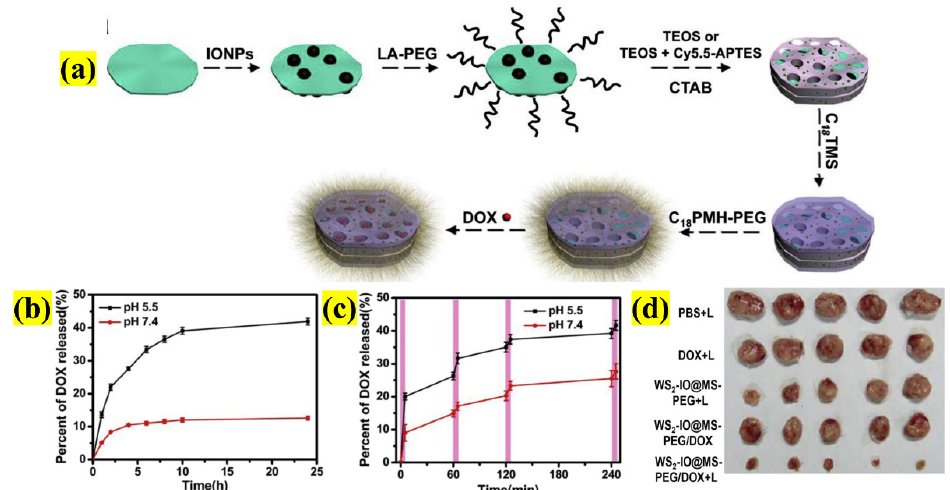
Figure 10. Schematic illustration of ( a ) the synthesis methodology of functionalized WS 2 with iron oxide NPs and DOX encapsulated with PEG as a nanocarrier, ( b ) DOX-release-designed NSs in buffers at different pH values, ( c ) NIR-triggered release of DOX at different pH values (5.5 and 7.4), and ( d ) images of tumors collected after 14 days’ treatment of various mouse groups (adapted with permission from Reference [64], Biomaterials, published by Elsevier, 2015).